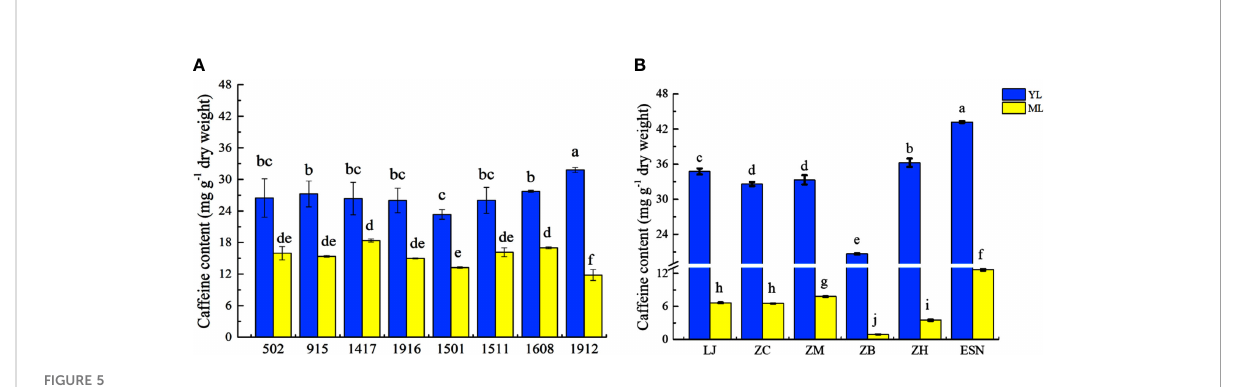
FIGURE 5 Caffeine content in different tea strains (A) and cultivars (B) .